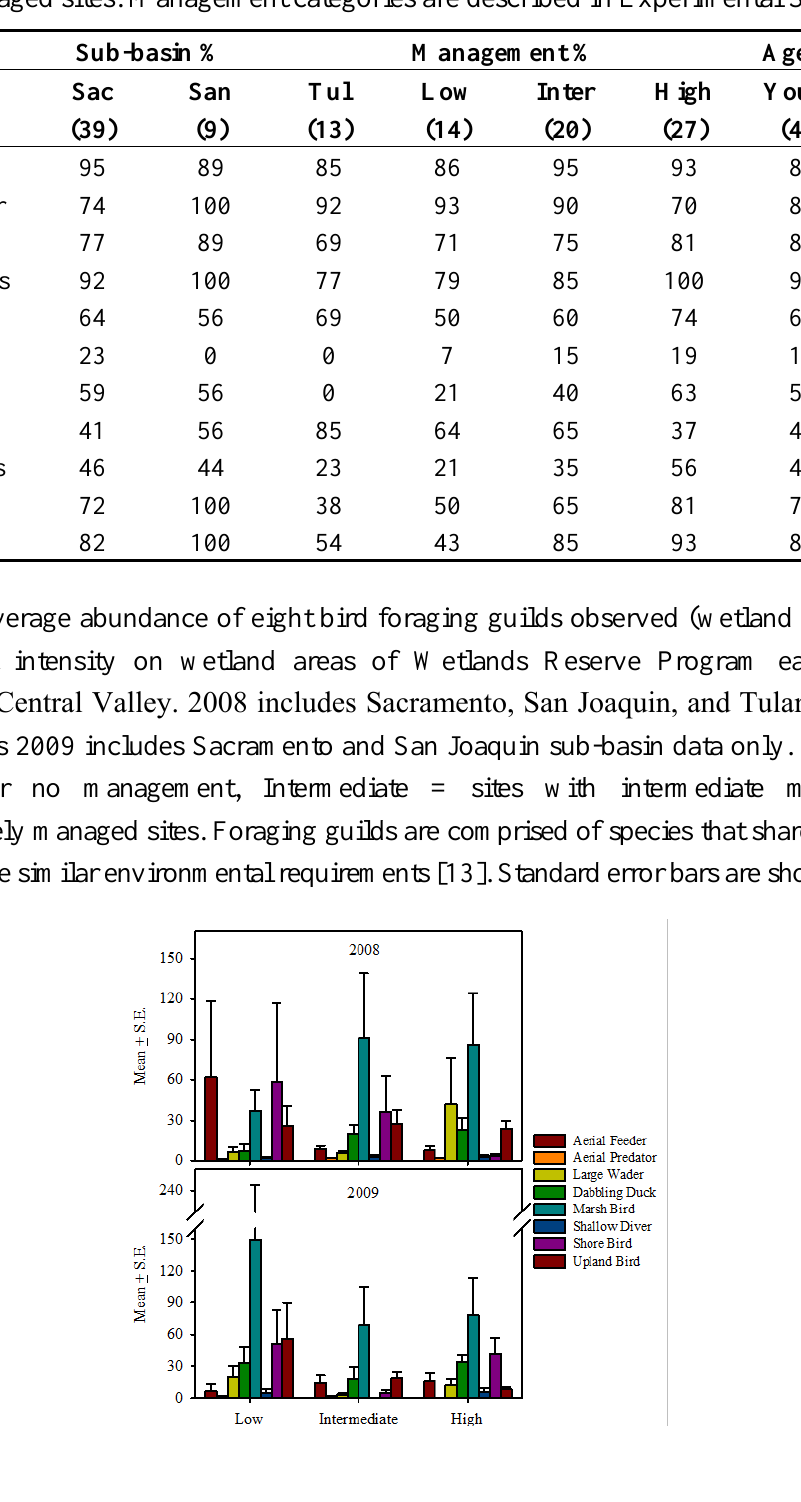
Table 5. Percent occurrence of avian foraging guilds in Wetland Reserve Program easements by sub-basin, management and age (2008–2009). Number of sites is indicated in parentheses. Sac = Sacramento sub-basin; San = San Joaquin sub-basin and ; Tul = Tulare sub-basin. ―Young‖ sites are ≤5 years since restoration; ―Old‖ are >5 years. ―Low‖ = sites under low or no management; ―Inter‖ = sites under intermediate management; ―High‖ = actively managed sites. Management categories are described in Experimental Section.